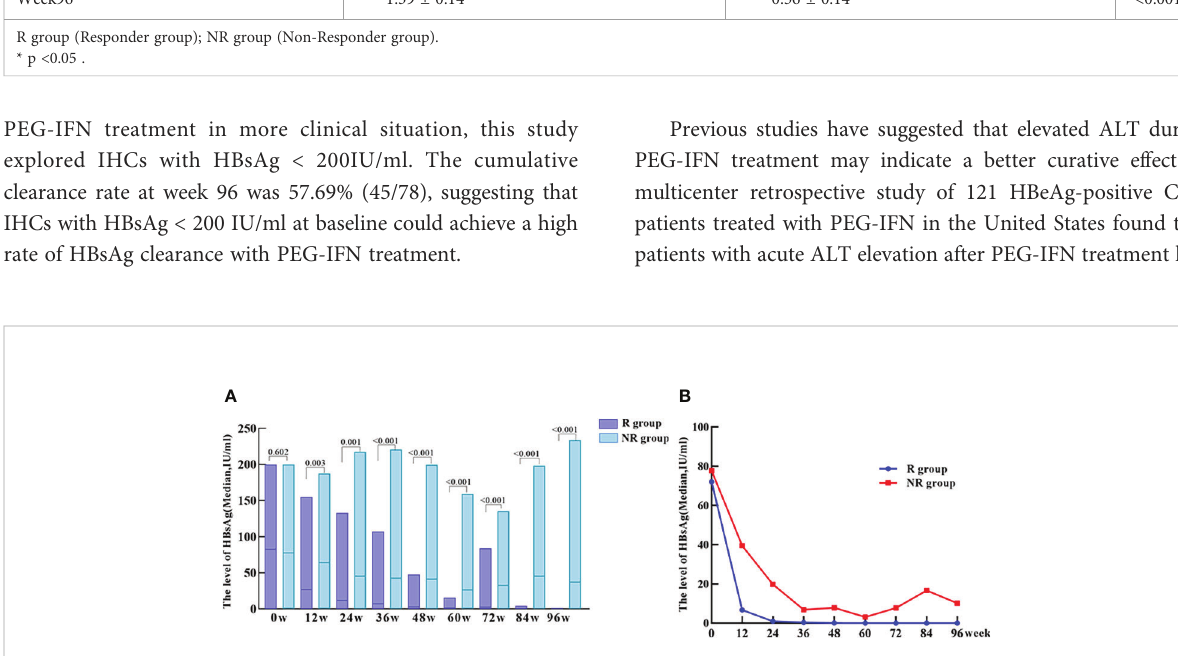
FIGURE 3 The level of HBsAg at baseline and during treatment of PEG-IFN in R and NR groups. (A) No signi fi cant difference of HBsAg level between R and NR group at baseline (p = 0.602). The level of HBsAg in R group was signi fi cantly lower than NR group during treatment (p = 0.003, p = 0.001, p < 0.001, p < 0.001, p < 0.001, p < 0.001, p < 0.001, P < 0.001) (B) HBsAg showed a signi fi cant downward trend after PEG-IFN treatment in IHCs, especially in R